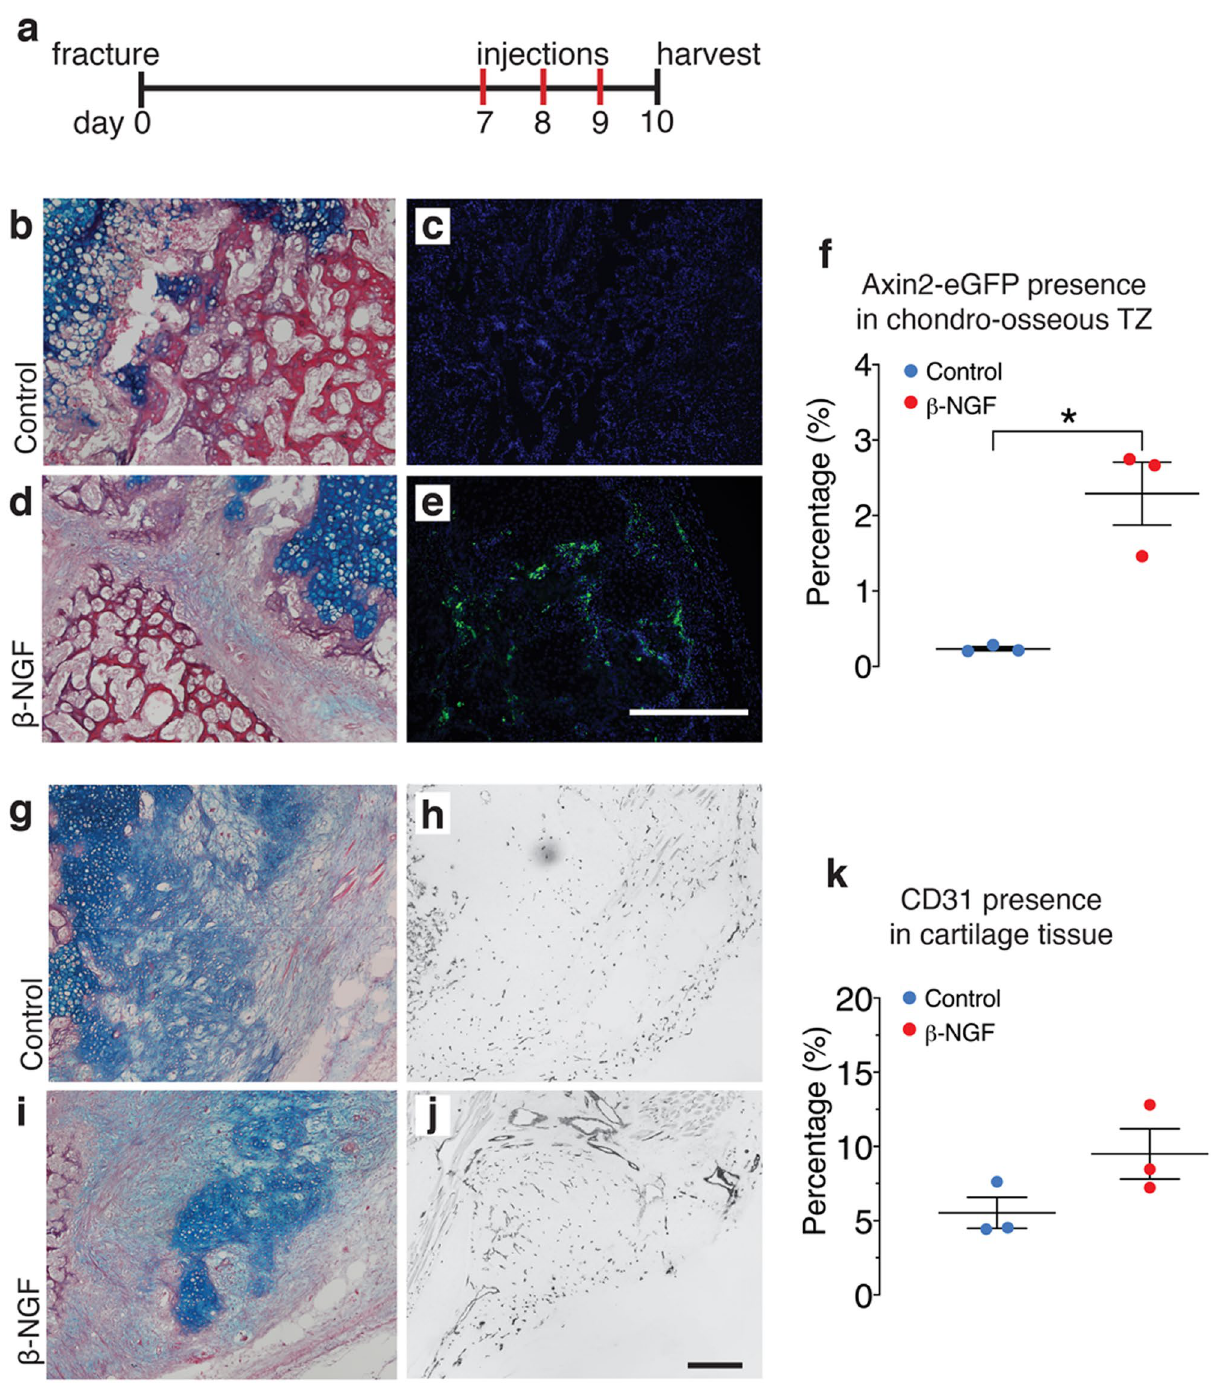
Figure 4. Local injections of β-NGF induce Wnt activation in the TZ and nominal increase of endothelial cell infiltration of cartilage callous. ( a ) Timeline schematic of fracture and subsequent daily injections of β-NGF. ( b ) Representative image of HBQ stained section of the chondro-osseous transition zone (TZ) from control group (media injections) with ( c ) a corresponding fluorescent DAPI-stained image of adjacent slide . ( d ) Image of HBQ stained TZ from β-NGF treated mice with corresponding ( e ) fluorescent DAPI stained image of an adjacent slide ( f ) Quantification of Axin2-eGFP presence within TZ of fracture callus as percentage (%) of area. Images of ( g ) HBQ stained section of cartilage tissue within fracture callus from control group and corresponding image ( h ) of Anti-CD31 Diaminobenzidine (DAB) stained section. ( i ) HBQ stained section from β-NGF treated group and corresponding ( j ) CD31-DAB stained section. ( k ) Quantification of DAB stain within cartilaginous tissue as percentage (%) of area. All scale bars = 500 μm. Error bars represent SEM. **p < 0.01; determined by 2-tailed t